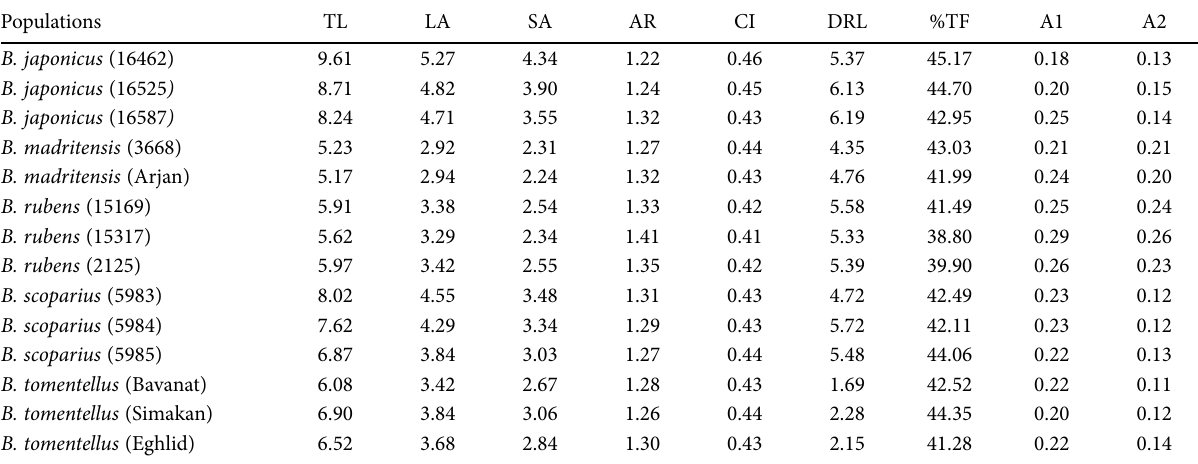
Table 3. Mean of chromosomes analysis of Bromus population. Populations